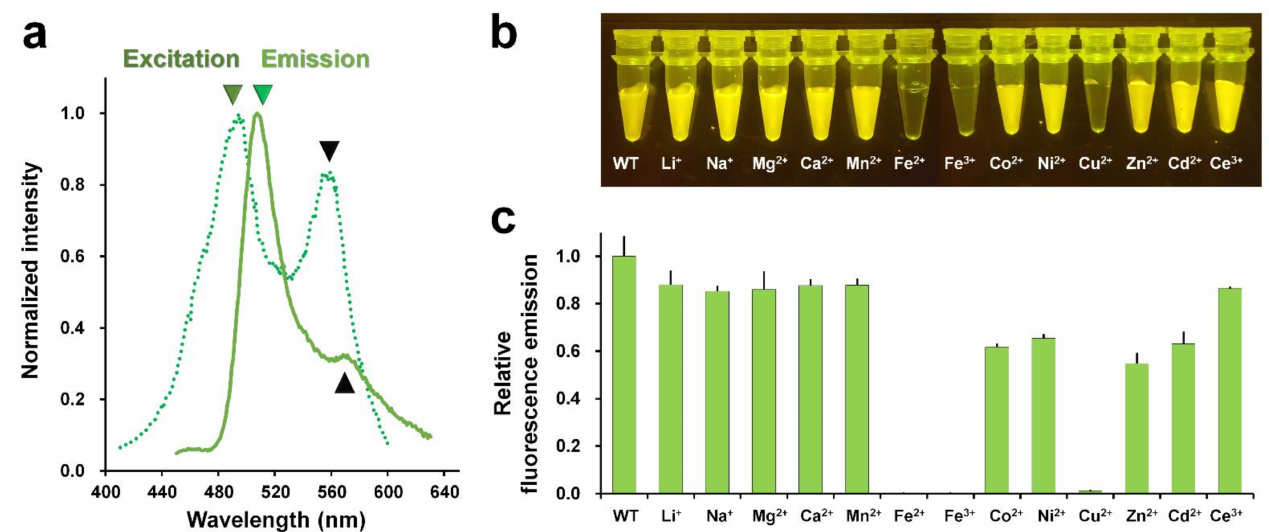
Figure 2. Metal screen for quenching DendFP. ( a ) Verification of purified DendFP by fluorescence spectral scanning. The maximum peaks of fluorescence excitation (forest, dot-line) and emission (green, line) are 494 and 507 nm, respectively. ( b ) Visualization of the metal-induced fluorescence quenching of DendFP. The sample mixtures containing DendFP (10 µ M, 50 µ L) and each of the metal ions (10 mM, 50 µ L) were exposed to LED light (470 nm). ( c ) Relative fluorescence emission intensity of DendFP in the presence of various metal